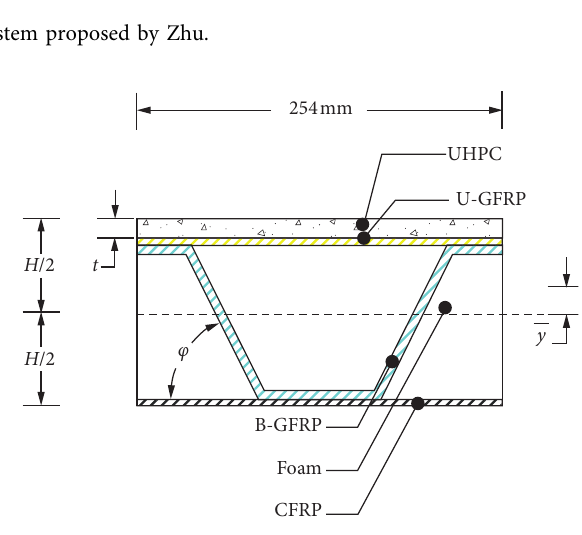
12: Hybrid deck system proposed by